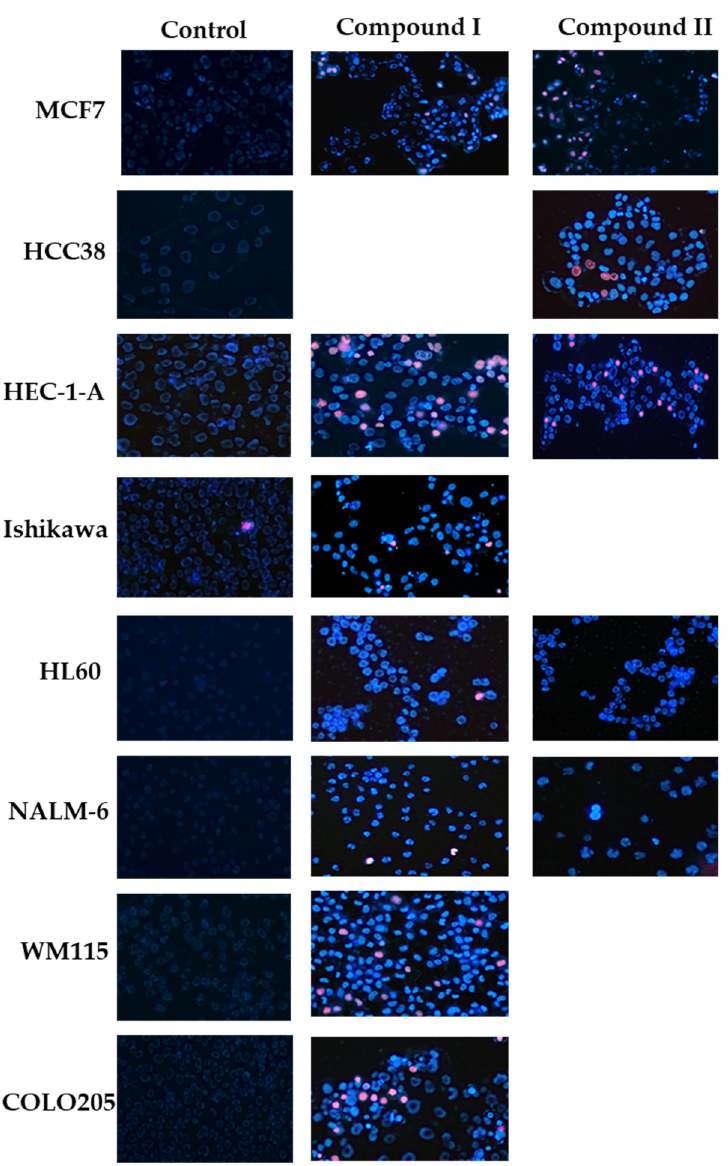
Figure 10. Analysis of the physiological state of single cancer cells MCF7, HCC38, HEC-1-A, Ishikawa, COLO205, HL60, NALM-6, and WM115 by fluorescent staining with the use of two fluorescent dyes—Hoechst 33258 and propidium iodide. Cancer cells were stained with fluorescent dyes to assess the integrity of the cell membrane and determine the fraction of living cells (pale blue fluorescence) and dead cells—including early/late apoptosis (bright blue/violet fluorescence) and necrosis (red fluorescence). Cells were incubated with derivatives for 24 h at concentrations of the calculated IC 50 .